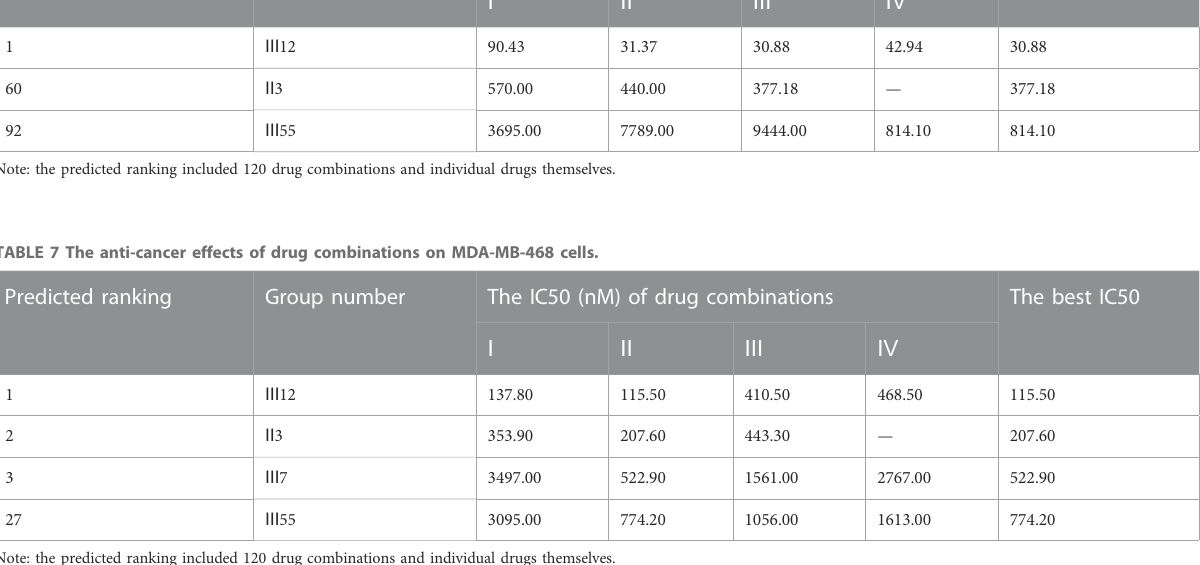
Figure S3). For the MDA-MB-231 cell line, the top two, IV33 and V32, exhibited strong synergistic effect at all drug ratios.